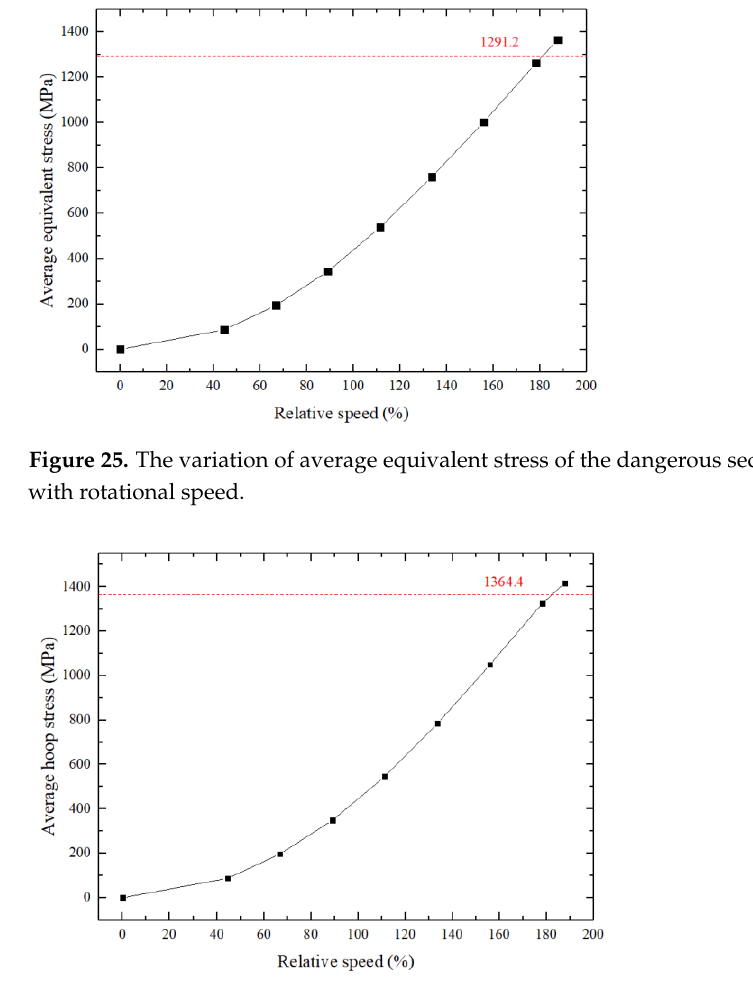
Figure 26. The variation of average hoop stress of the dangerous section of vortex reducer with rotational speed. Table 5. Burst speed predicted by different criteria.